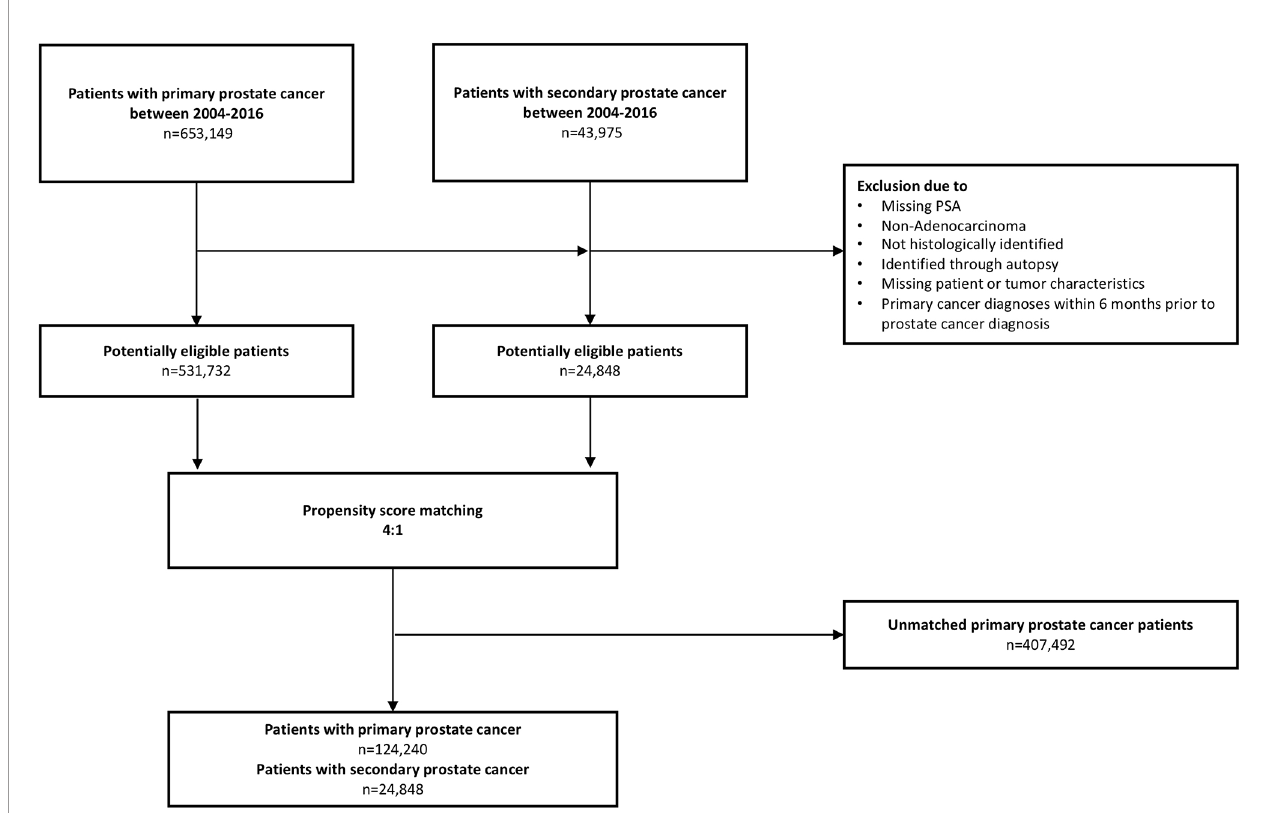
FIGURE 1 | Flow chart depicting included patients with primary and secondary prostate cancer in